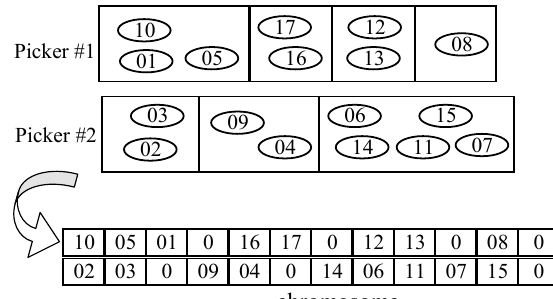
Figure 3. An example for a chromosome.